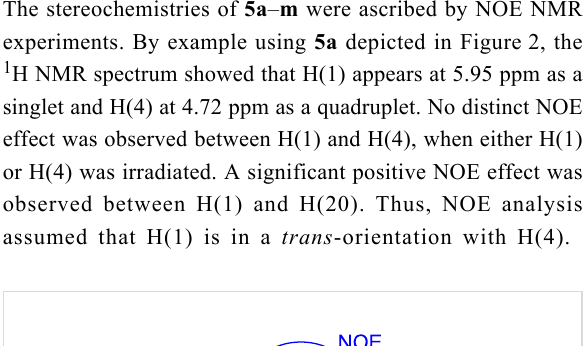
C(3)–O(1) with similar distances of 1.222 and 1.218 Å, respec- tively. The intramolecular hydrogen bond O(1)–H(13)